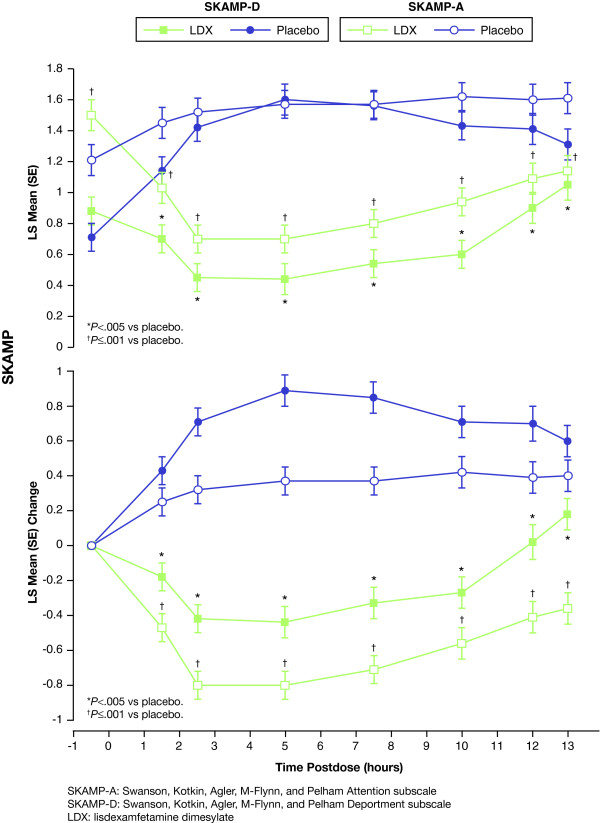
Time course of SKAMP-D (closed symbols) and SKAMP-A (open symbols) assessment over the laboratory school day. LS mean (SE) actual scores (top) and change from predose (bottom) for LDX (squares) and placebo (circles) at predose (-0.5 h) and at 1.5, 2.5, 5, 7.5, 10, 12, and 13 h postdose. Scores were compared using a linear mixed model with sequence, period, and treatment as fixed effects and subject within sequence as a random effect. Lower scores denote improvement. *Denotes P < .005 LDX compared with placebo for SKAMP-D. †Denotes P ≤ .001 LDX compared with placebo for SKAMP-A.